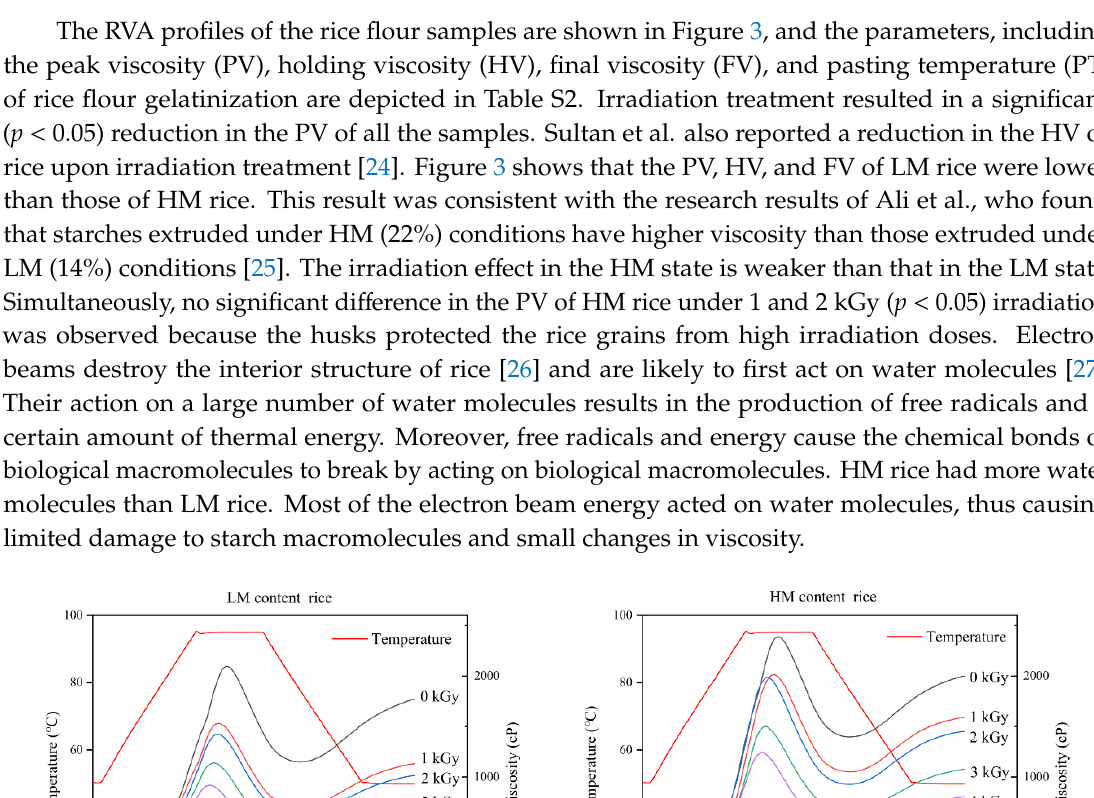
Figure 2. Water distribution in LM rice and HM rice samples after 30 min of soaking and treatment with different irradiation doses. ( a ) Control LM rice before and after 30 min soaking, ( b ) Control HM rice before and after 30 min soaking, ( c ) 4 kGy LM rice before and after 30 min soaking, ( d ) 4 kGy HM rice before and after 30 min soaking.